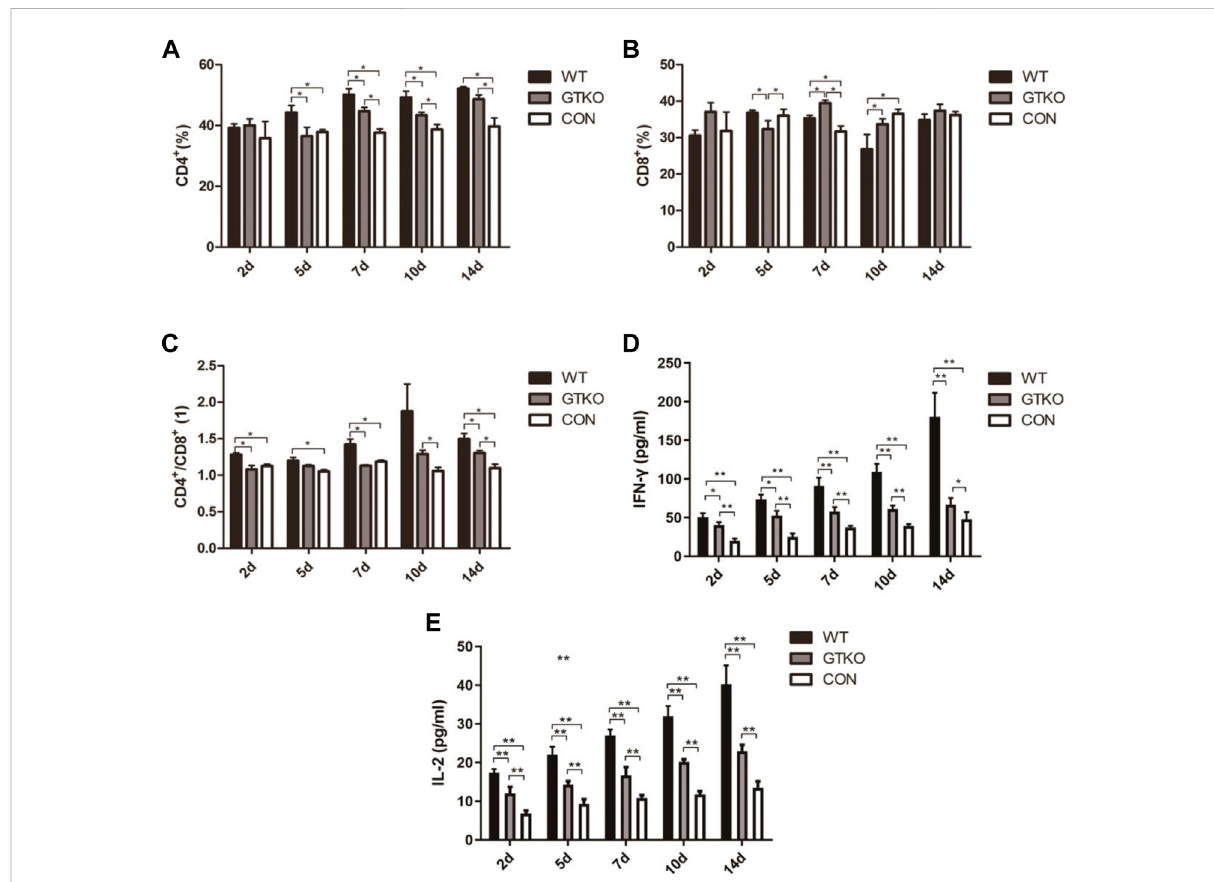
FIGURE 1 Immunological assessment of xenotransplant rejection. (A) Statistical analysis of the percentage of CD4 + T lymphocytes in rhesus monkeys transplanted with the materials shown at 2, 5, 7, 10, and 14 days after surgery. WT: defect repaired with WT-pig cancellous bone plug; GTKO: defect repaired with GTKO-pig cancellous bone plug; CON: control group (no treatment); (B) Statistical analysis of the percentage of CD8 + T lymphocytes intherhesus monkeystransplantedwiththematerialsshownat2,5,7,10,and14 days aftersurgery; (C) StatisticalanalysisoftheratioofCD4+/ CD8+ T lymphocytes in the rhesus monkeys transplanted with the materials shown at 2, 5, 7, 10, and 14 days after surgery. (D) Statistical analysis of IFN- γ in the peripheral blood serum of rhesus monkeys transplanted with the materials shown at 2, 5, 7, 10, and 14 days after surgery; (E) Statistical analysis of IL-2 from the peripheral blood serum of rhesus monkeys transplanted with the materials shown at 2, 5, 7, 10, and 14 days after surgery. Dataareshownasmean±S.D.* p < 0.05.GTKO, α 1,3-galactosyltransferase-knockoutpigcancellous bonegroup;WT,wildtypepigcancellous bone group; Con, unrepaired defect